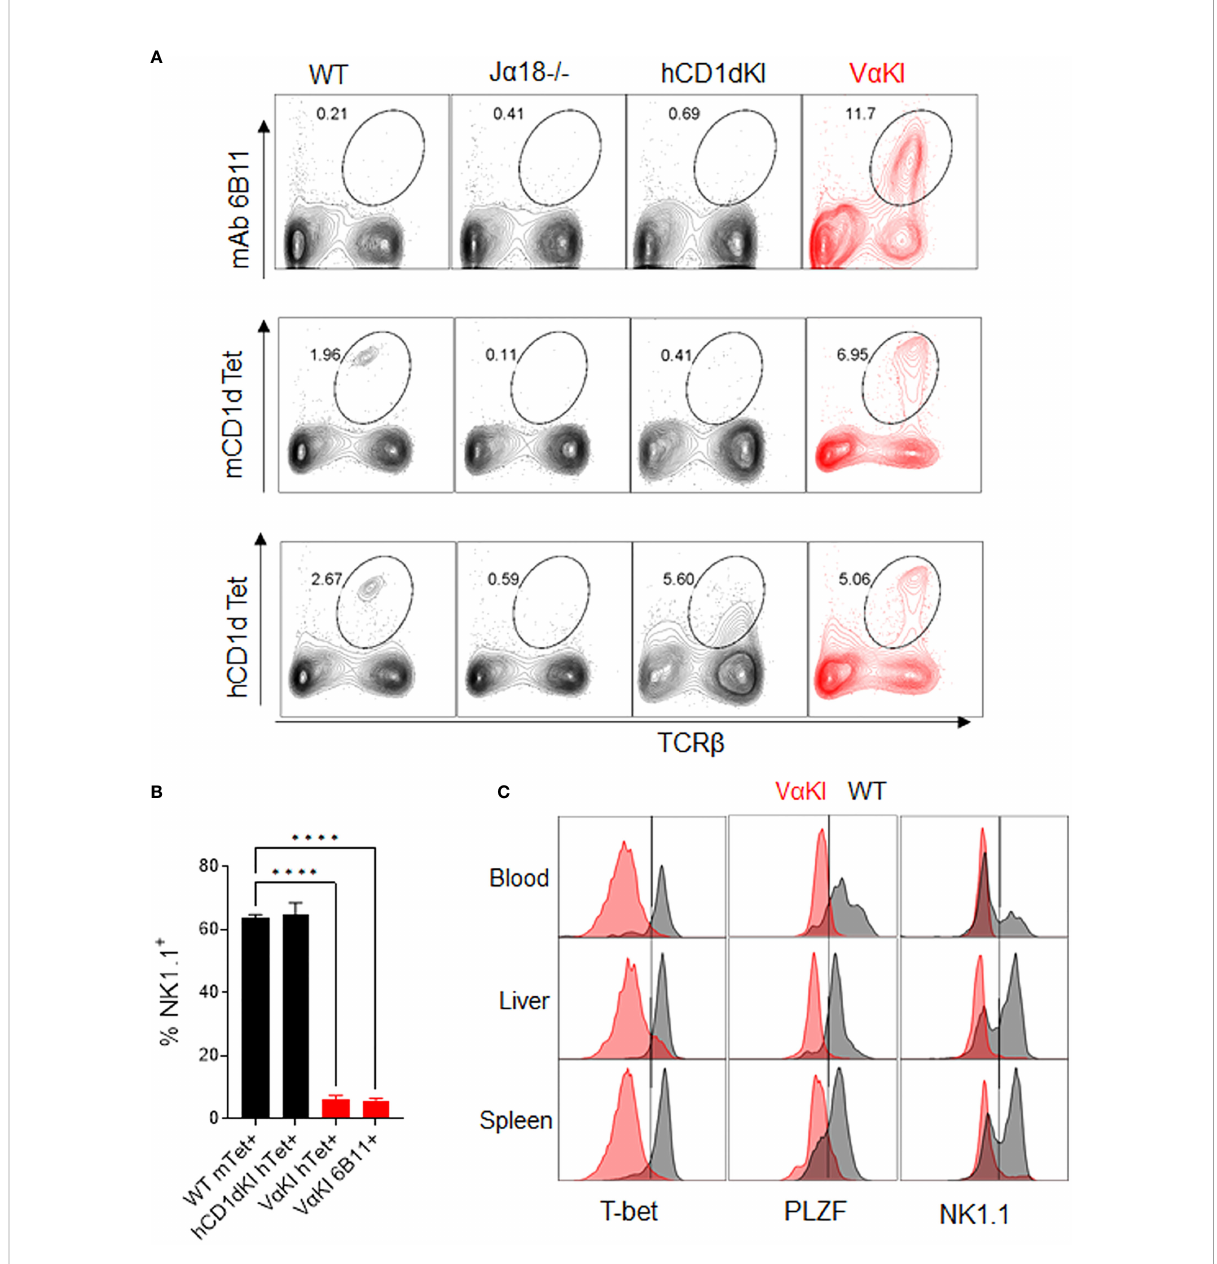
FIGURE 2 V a 24 transgene expression and CD1d tetramer binding of V a KI T cells. (A) Spleen cells from WT, J a 18-/-, hCD1dKI and V a KI mice were stained with mouse or human CD1d tetramers loaded with a GalCer glycolipid PBS-57, or with anti-human V a 24-J a 18 TCR speci fi c mAb 6B11. Numbers in plots are percentages of total lymphocytes within the area enclosed by the ovals. (B) Percentages of NK1.1+ cells among gated CD1d tetramer + or 6B11+ cells in spleens of WT, hCD1dKI or V a KI mice. (C) Histograms of CD1d tetramer+ cells (Zombie negative, B220 negative, TCR b +, CD1dTet+) showing their NK1.1, PLZF and T-bet expression in blood, liver, and spleen (V a KI mice shaded red and on WT C57BL/6 in black). Results shown are representative of three separate analyses. ****P < 0.0001 (one-way Anova with Tukey post